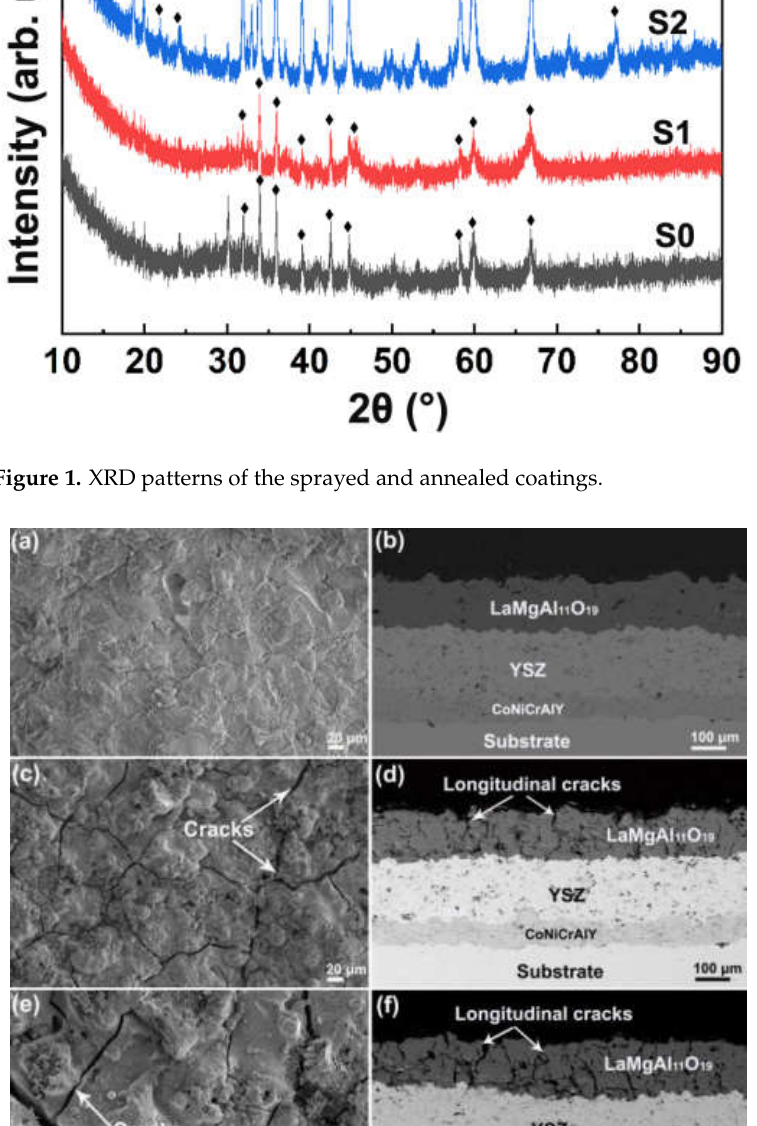
Figure 1. XRD patterns of the sprayed and annealed coatings.